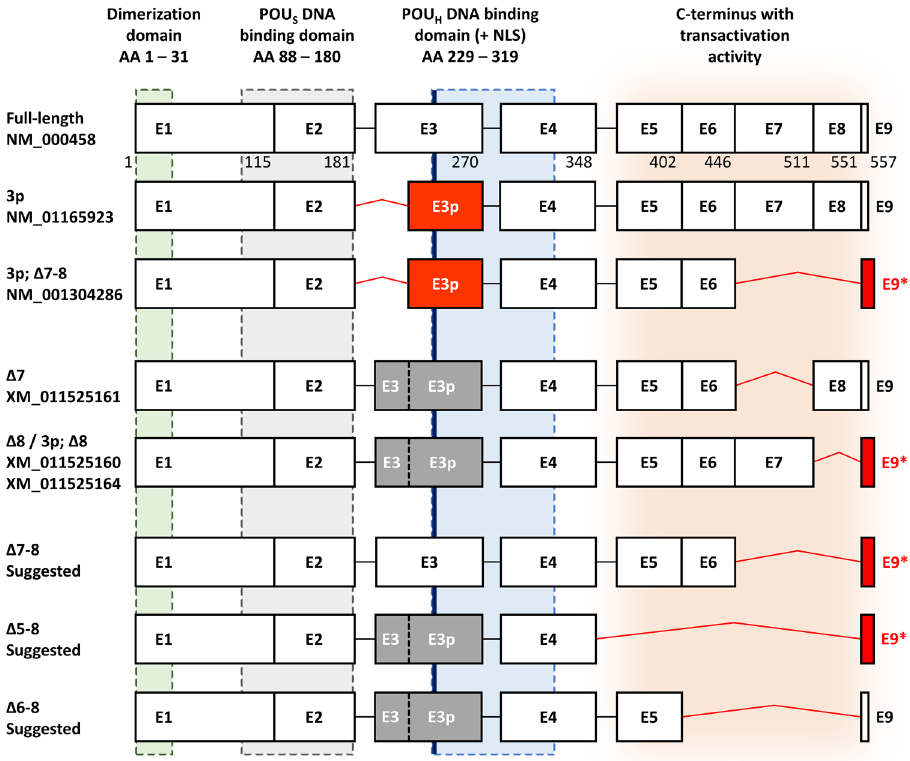
Figure 1. Scheme of the proposed HNF1B splicing pattern. White boxes represent canonical exons, black lines represent canonical exon-exon junctions. Red boxes represent alternatively spliced exon (E3p) or exon with alternative stop codon (E9*), red lines represent confirmed alternative exon-exon junctions. Gray boxes represent undetermined variant of exon 3 in suggested transcripts. The lengths of the exons are proportional. Amino acid (AA) numbers are indicated below the exon boxes of full-length transcript. The green, grey, blue, and orange areas illustrate the coding areas for functional domains across the HNF1B transcripts. NLS nuclear localization signal (thick blue line). POU S POU specific domain. POU H POU homeodomain. The scheme of HNF1B transcripts is based on previous findings 19 and actual RefSeq database